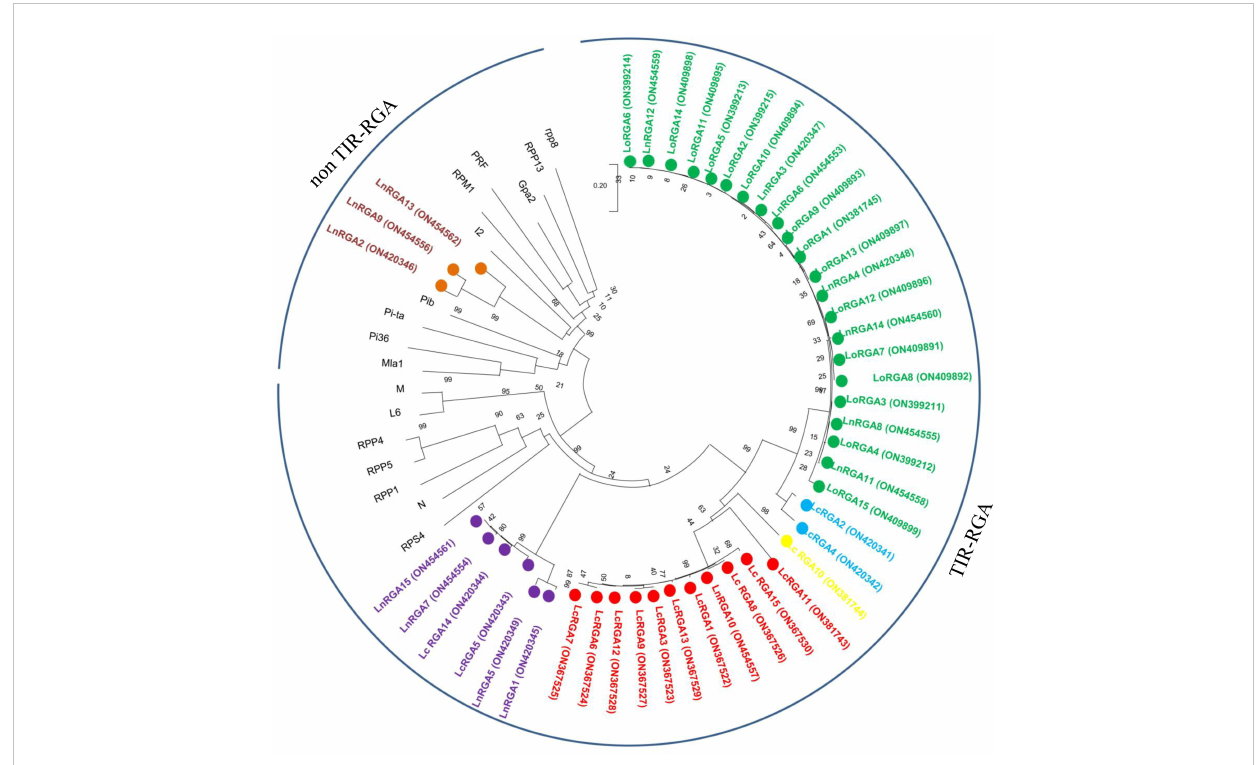
FIGURE 6 Neighbor-joining phylogenetic tree constructed based on isolated Lentil RGAs and known NBS region of R gene, N (U15605), L6 (U27081), M (U73916), RPP5 (AAFO8790.1), RPP4 (AAM18462.1), RPP1 (AT3444670), RPS4 (CAB50708.1), Mla (AAG37356), Pi-ta (ACY24970.1), Pi36 (ADF29629.1), Pib (BAA76282.2), I2 (AF004878), RPP13 (AAF42831), RPM1 (AQ39214), Prf (U65391), Gpa2 (AF195939), RPP8 (AAC78631.1.), FOM-2 (AY583855.1) at bootstrap values (10000 replicates). Numbers on the branches indicate the percentage of bootstrap replications. Green represents LRGA 1, blue represents LRGA 2, yellow represents LRGA 3, red represents LRGA 4, purple represents LRGA 5, and orange represents LRGA 6.